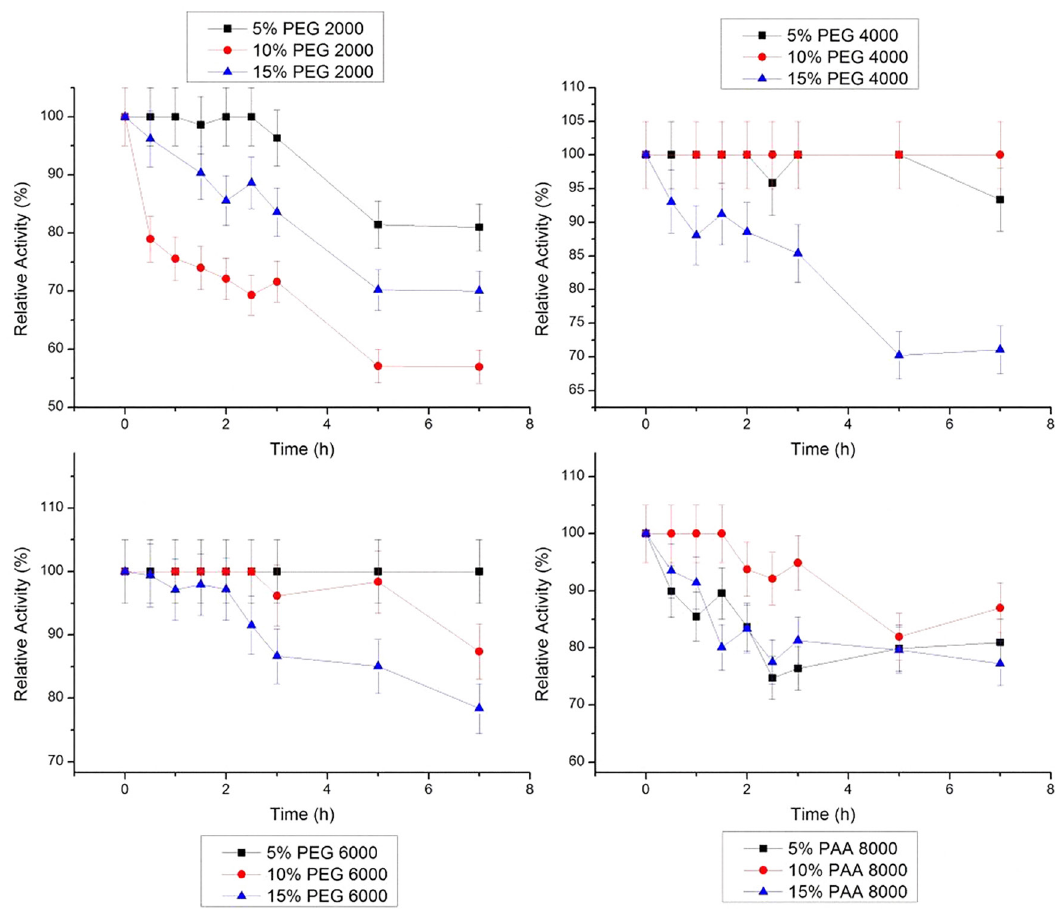
FIGURE 6 - Relative stability of bromelain at 30 °C in PEG 2000, 4000, 6000 g/mol and PAA 8000 g/mol at three concentrations (5, 10 and 15% w/w). The error bars refer to standard